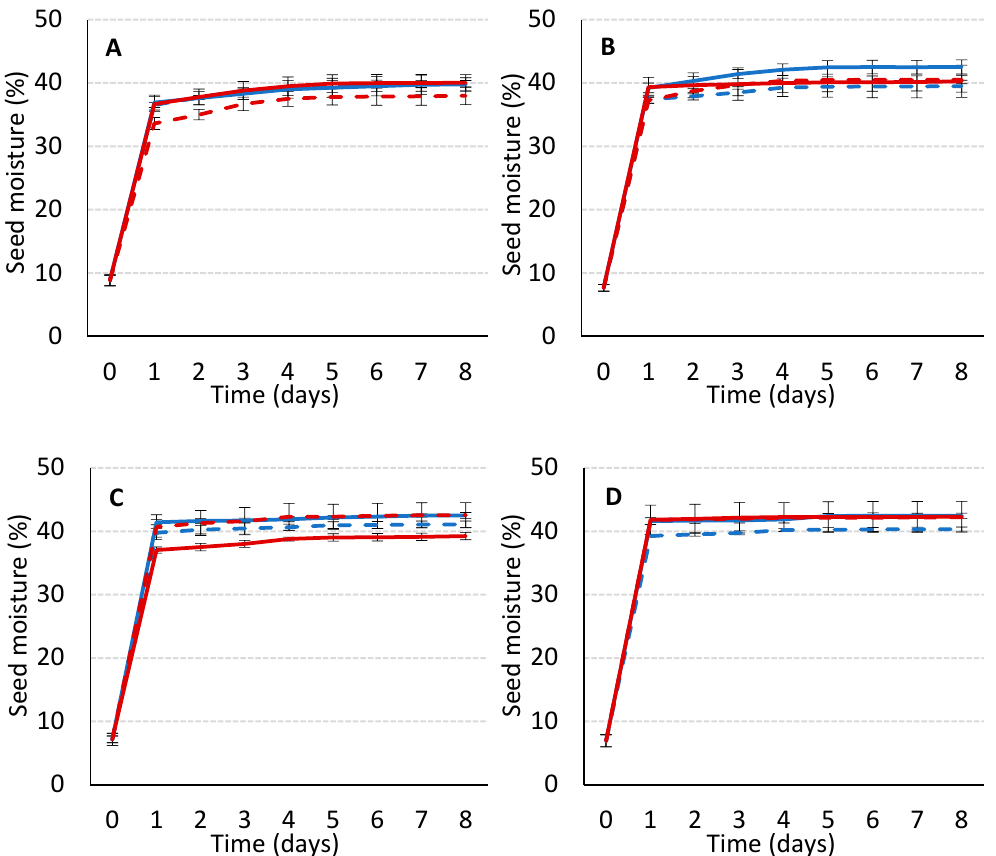
Figure 2. The seed moisture content (%) along the soaking period. Mean values for combinations of four caper seed categories (intact seeds ( A ); scrapped seeds ( B ); cracked seeds ( C ); and broken seeds ( D )), two imbibition mediums (between paper in blue and in a 10 cm column in red), and imbibition medium (water in continuous lines and GA solution in dashed lines). Vertical bars represent the standard error.